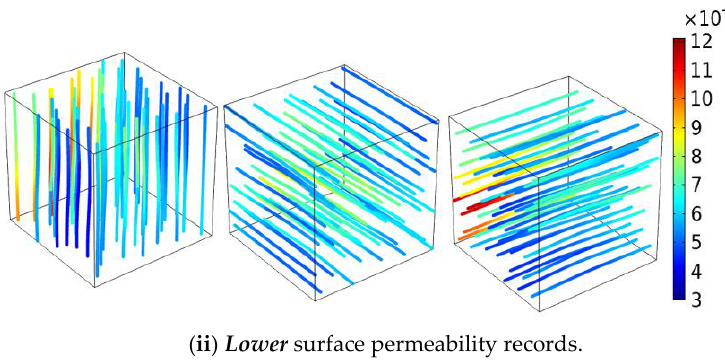
Figure 21. Computational results of flow patterns in three orthogonal directions obtained for the cuboid of Lac du Bonnet granite.